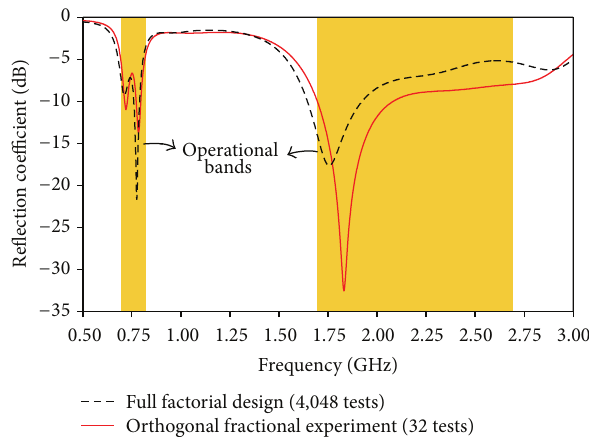
Figure 7: Comparison of the optimized internal antennas between the full factorial design and the orthogonal fractional experiment.